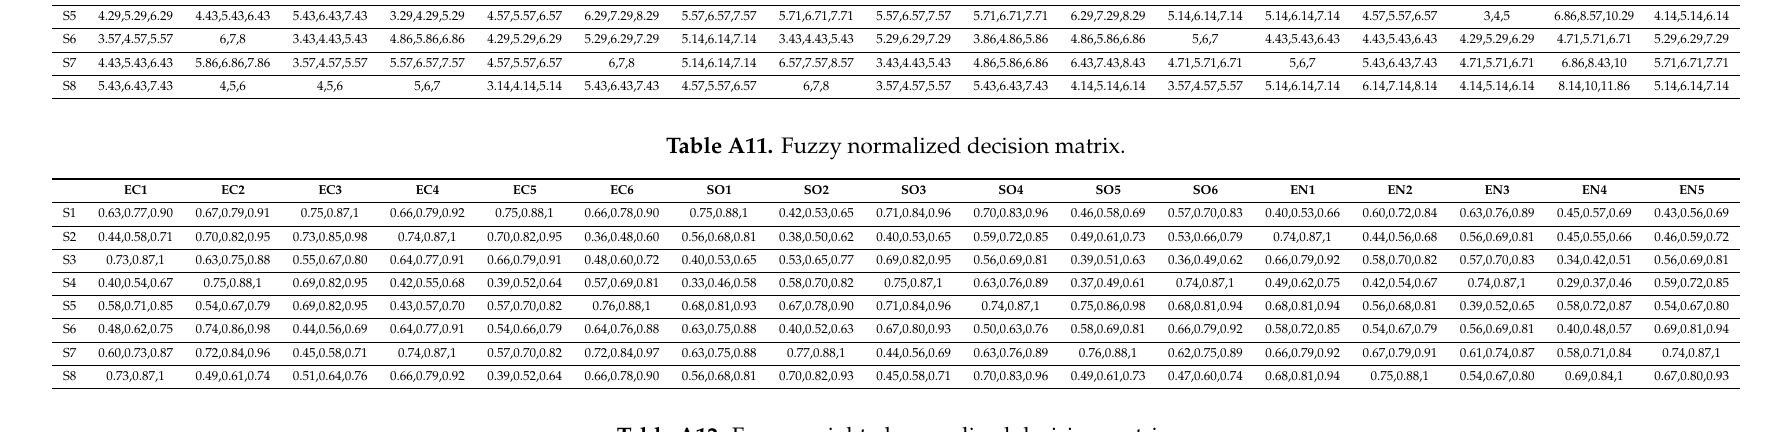
Table A12. Fuzzy weighted normalized decision